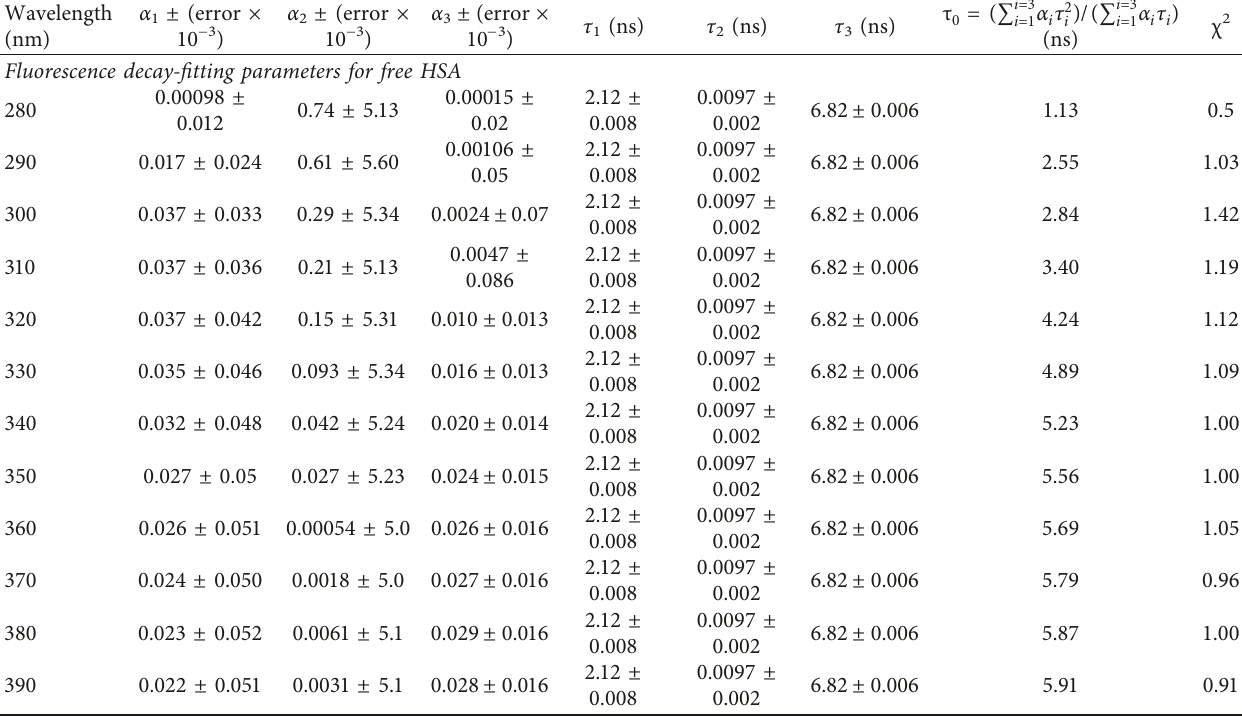
Figure 3: (a) Time-resolved emission spectroscopy (TRES) studies of HSA (1 µ M) with the drug complex (1 µ M) of different wavelength decay parameters. (b) Global fitted τ 0 value for each wavelength of the respective HSA and HSA-coumarin derivative. Table 2: Fluorescence lifetime profiles of HSA and increasing concentration of coumarin derivatives at different excitation wavelengths.